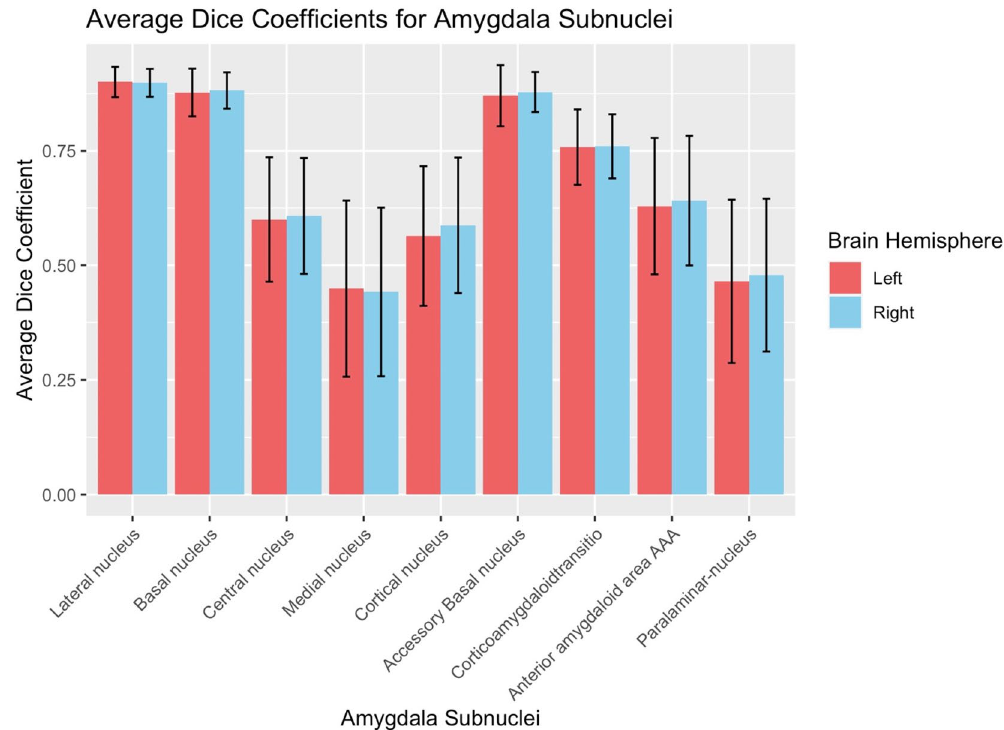
Fig. 5 Amygdala Dice coefficient values for all Amygdala subnuclei. Error bars represent 1 standard deviation above and below the